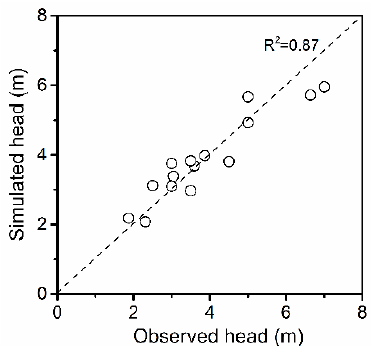
Figure 5. The comparison of observed and simulated groundwater head of 15 monitoring wells at the end of September 2008.